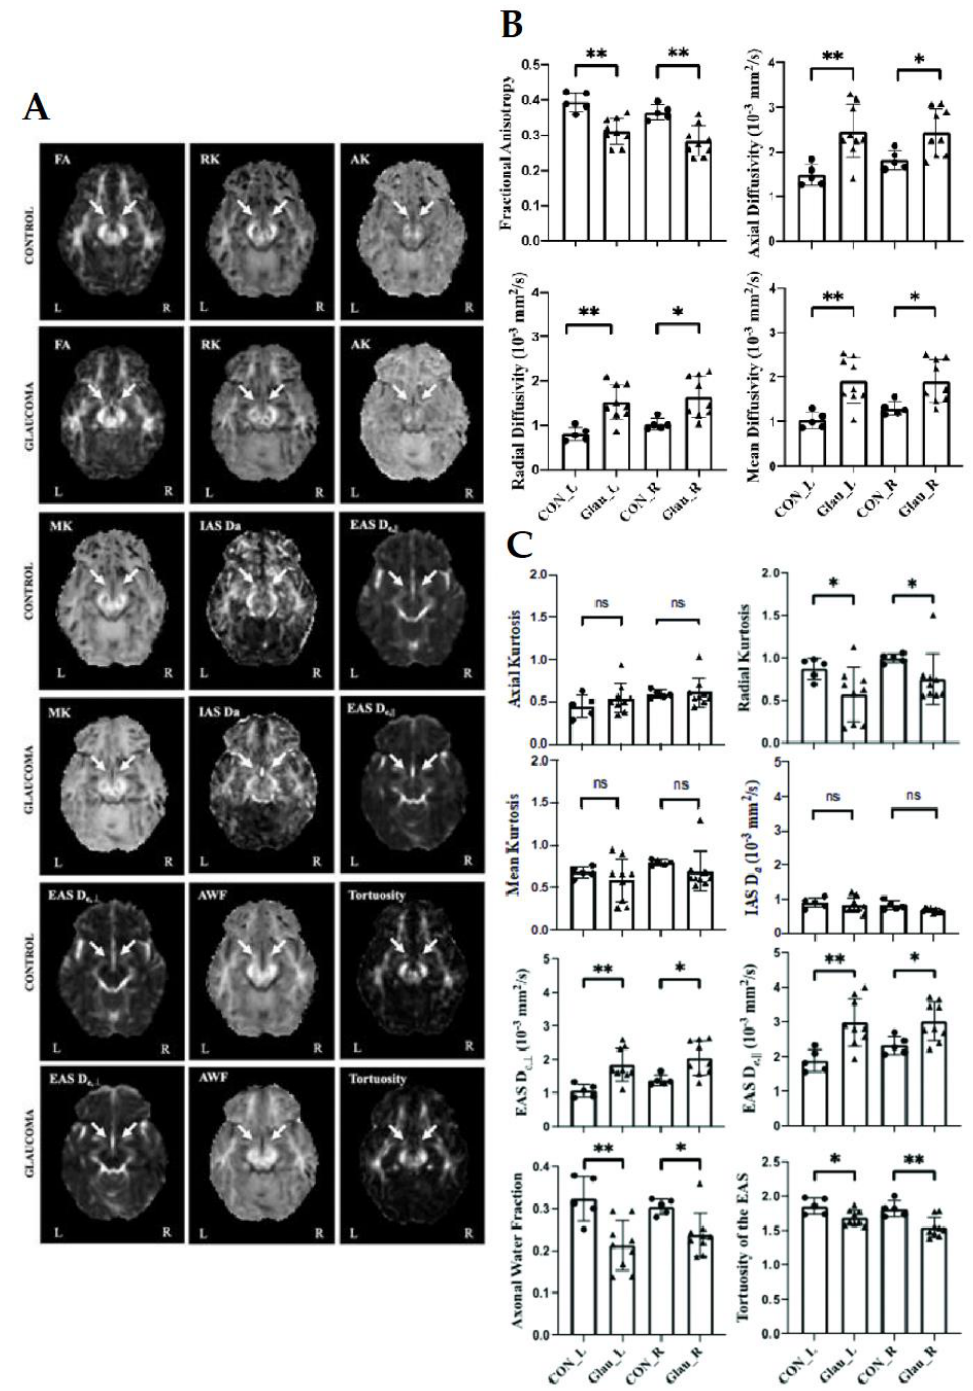
Figure 8. ( A ) Representative parametric maps of DTI [fractional anisotropy (FA)], DKI [radial kurtosis (RK), axial kurtosis (AK), mean kurtosis (MK)], and WMTI models [axial IAS diffusivity (D a ), axial EAS diffusivity (D e,// ), radial EAS diffusivity (D e, ⊥ ), axonal water fraction (AWF), tortuosity of the EAS (ratio of D e,// and D e, ⊥ )] from glaucoma and healthy control groups at the level of the optic tracts (arrows). ( B , C ) Quantitative comparisons of DTI ( B ) and DKI and WMTI parameters ( C ) in the left (L) and right (R) optic tracts of glaucoma (Glau) and healthy control (CON) groups. Unpaired t-tests between glaucoma and healthy groups, * p < 0.05; ** p < 0.01; ns: not significant. Images are adapted with permission from Sun et al.